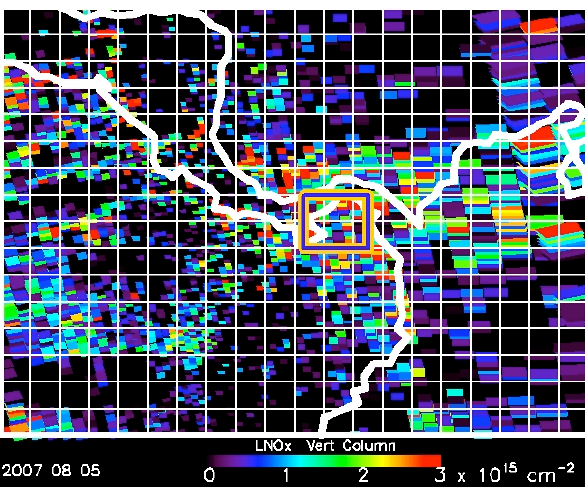
Fig. 4. The altitude vs. time of the ozonesonde flight on 5 August 2007 from Las Tablas, Panama shows the balloon oscillating 5 times between ∼ 2.5 and ∼ 5.1km. The color coding of each ascent will be used in successive plots to identify changes with time of other measured parameters.